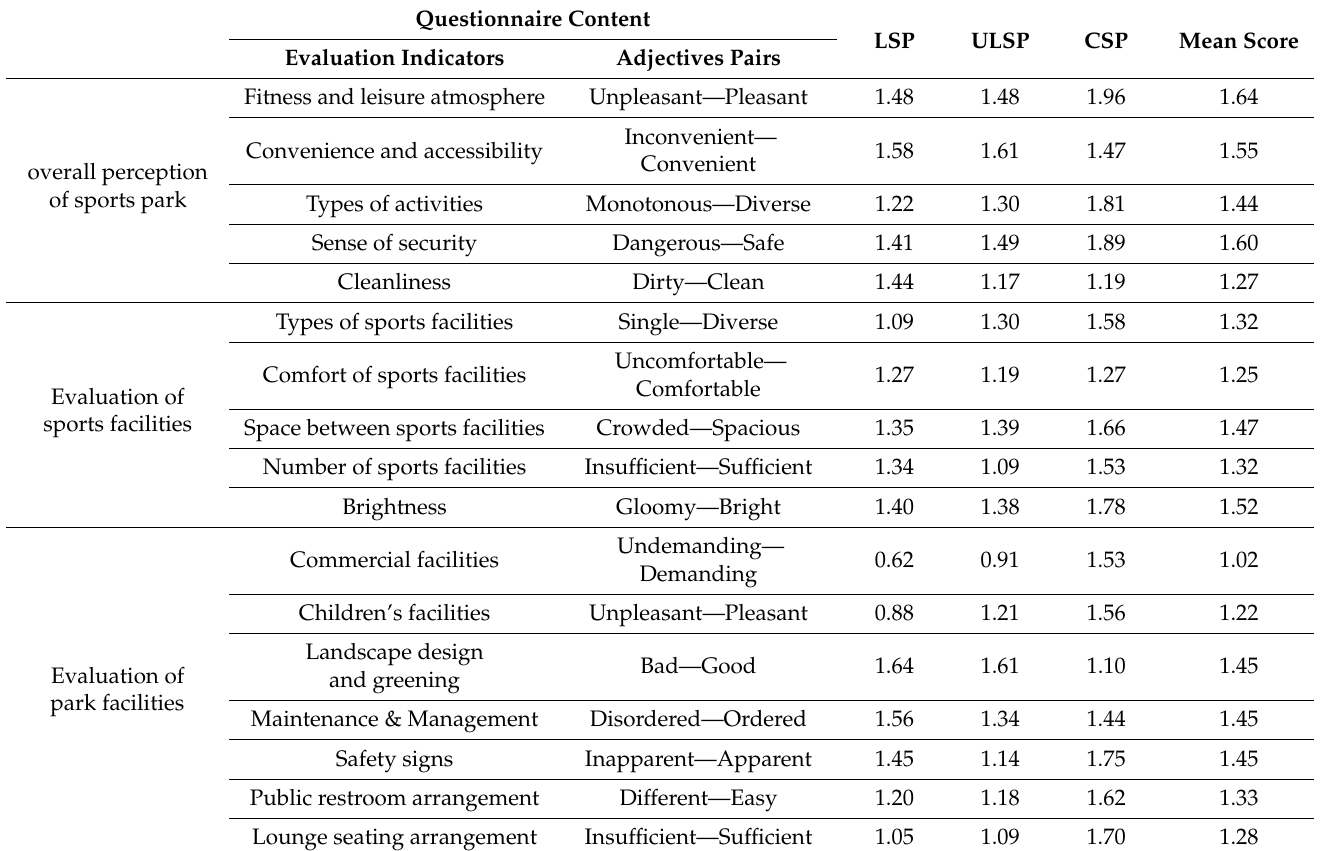
Table 4. Statistical results of the evaluation indexes of the three sports